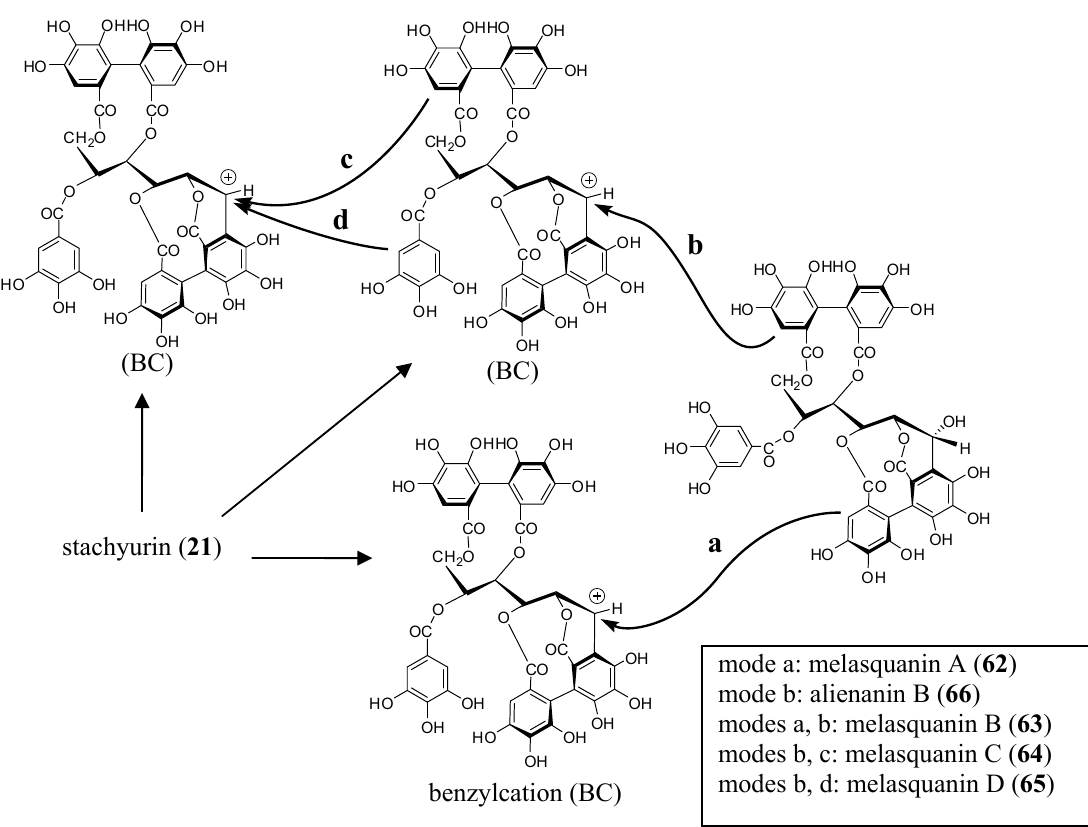
Figure 8. Coupling modes (a–d) to melasquanins A ( 62 )–D ( 65 ).